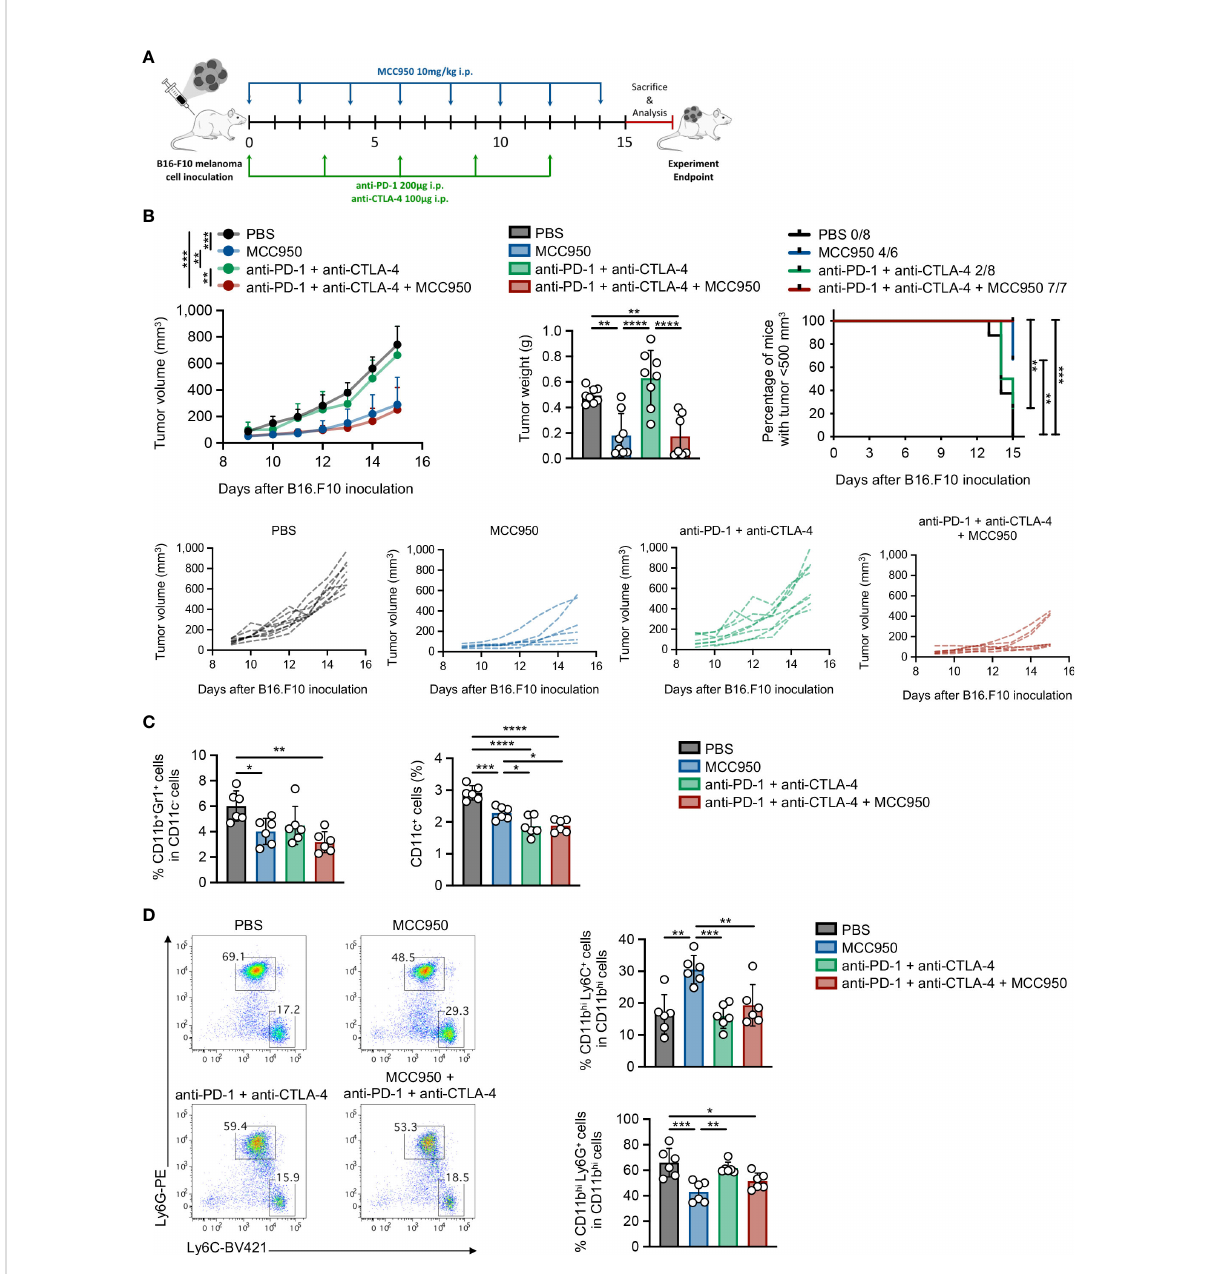
FIGURE 8 Pharmacologic inhibition of NLRP3 attenuates tumor growth and re-programs the MDSC compartment. (A) Experimental protocol for immunotherapy administration. B16.F10 melanoma-bearing C57BL/6J mice were treated with MCC950, anti-PD-1, and anti-CTLA-4 immune checkpoint inhibitors, or PBS as shown. Analysis was performed 15 days after tumor induction. (B) Tumor volume curve 9 – 15 days after B16.F10 inoculation, tumor weight on the experiment endpoint, and percentage of mice bearing tumors<500 mm 3 , with the ratio showing the number of mice with tumor<500 mm 3 /total injected mice (PBS: n = 8; MCC950: n = 8; anti-PD-1/anti-CTLA-4: n = 8; MCC950 + anti-PD-1/anti-CTLA- 4: n = 7). (C) Frequencies of MDSCs and DCs in spleen tissue of B16.F10 melanoma-bearing C57BL/6J mice treated with the indicated treatments (PBS: n = 6; MCC950: n = 6; anti-PD-1/anti-CTLA-4: n = 6; MCC950 + anti-PD-1/anti-CTLA-4: n = 6), determined by fl ow cytometric analysis. (D) Representative FACS plots and frequencies of spleen-in fi ltrating M-MDSCs and G-MDSCs subsets of B16.F10 melanoma-bearing C57BL/6J mice treated with the indicated treatments (PBS: n = 6; MCC950: n = 6; anti-PD-1/anti-CTLA-4: n = 6; MCC950 + anti-PD-1/anti-CTLA-4: n = 6), determined by fl ow cytometric analysis. Data are shown as mean ( ± S.D.). Data from one (C, D) and representative data from two (B) independent experiments are shown. Statistical signi fi cance was obtained by one-way ANOVA with Tukey ’ s multiple comparison test or log(rank) test (B) . Symbols: (*), p ≤ 0.05; (**), p ≤ 0.01; (***), p ≤ 0.001; (****), p ≤ 0.0001, n = biologically independent mouse